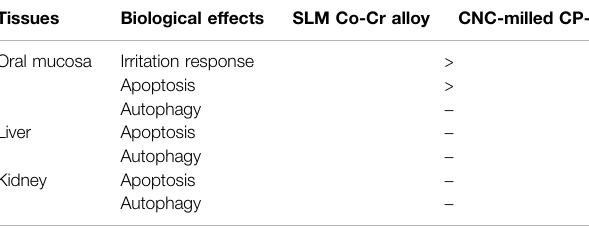
TABLE 5 | Differences in biocompatibilities between the SLM Co-Cr alloy and CNC-milled